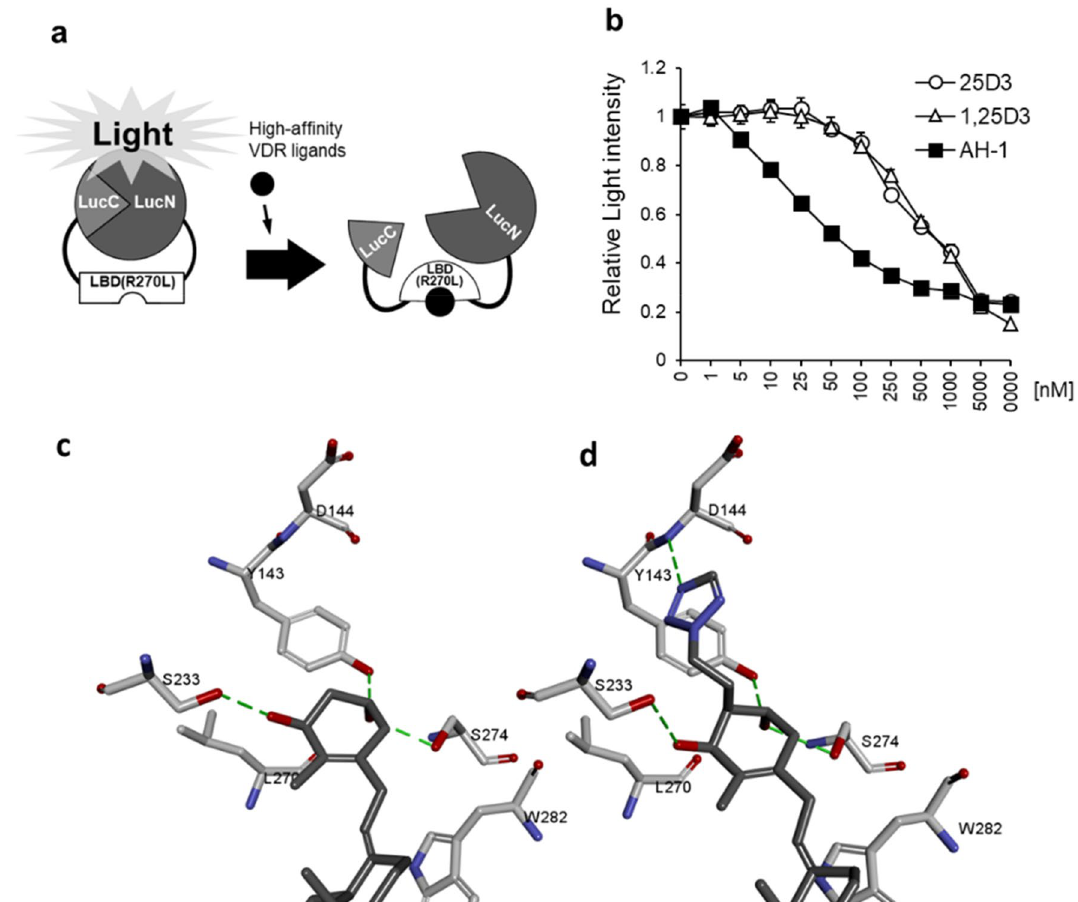
Figure 2. Interaction between AH-1 and Vdr(R270L). ( a ) Detection mechanism of the LucC-rat LBD(R270L)- LucN biosensor. Binding of the high-affinity Vdr ligand to the LucC-LBD(R270L)-LucN biosensor may cause a conformational change of LBD(R270L), and then disruption of the functional complex between LucN and LucC fragments of the split luciferase. ( b ) Comparison of binding affinity of 25(OH)D 3 , 1,25(OH) 2 D 3 or AH-1 to LBD of rat Vdr. The relative light intensity compared to the control (0 nM = 1% EtOH) was shown. Data are represented as mean ± SEM (n = 3). ( c ) Complex structures of R270L mutant Vdr with 1,25(OH) 2 D 3 . ( d ) Complex structures of R270L mutant Vdr with AH-1, in which the A-ring parts are magnified. The carbon atoms are colored by grey for the ligands and by white for the amino-acid residues. Green dotted lines show hydrogen